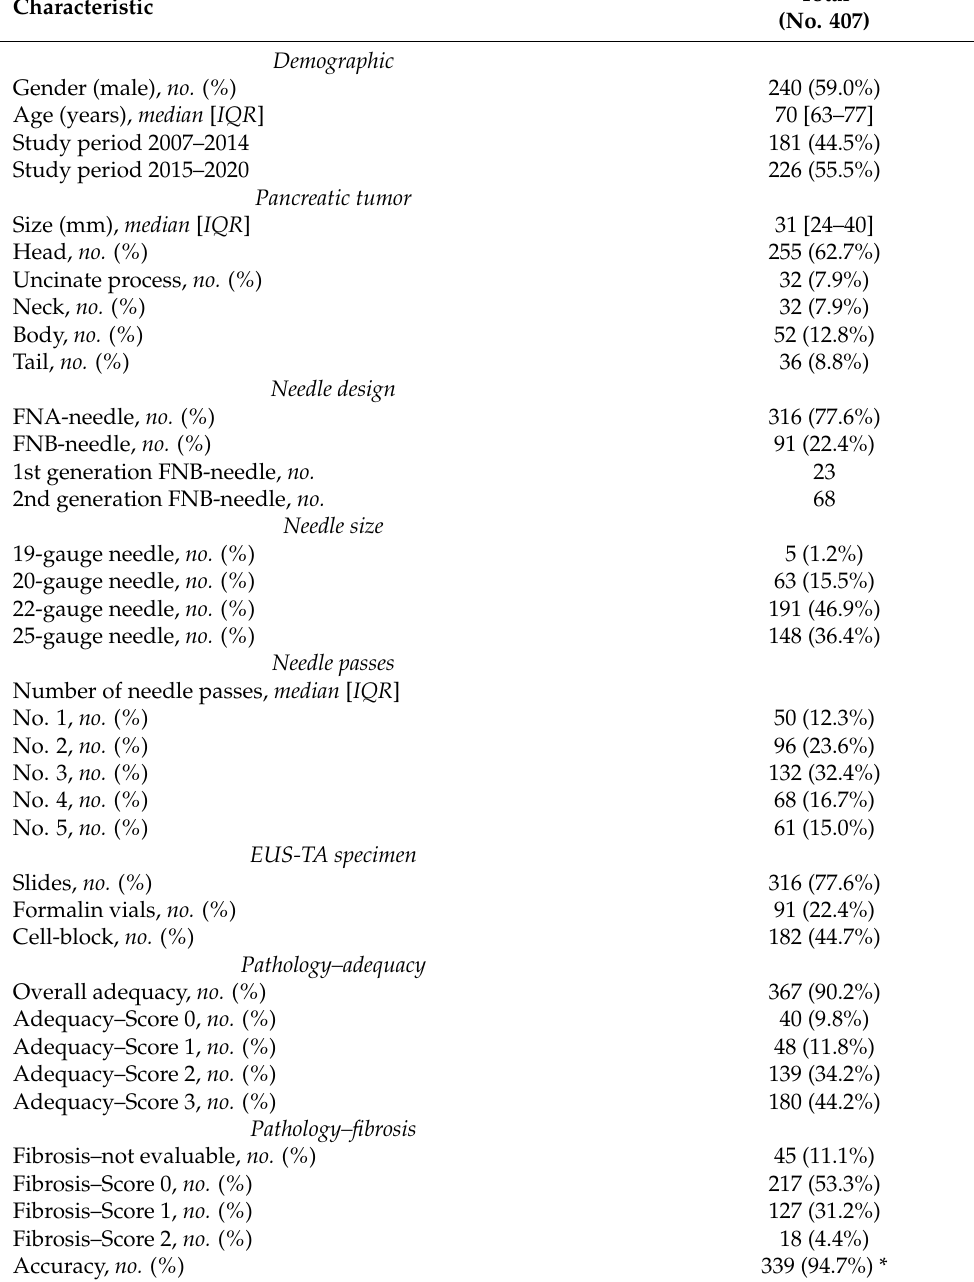
Table 1. Baseline characteristics of the study population.